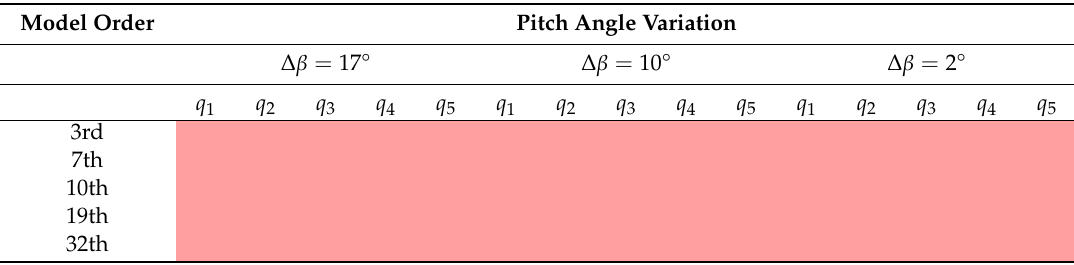
Table 7. Kharitonov stability results a = −